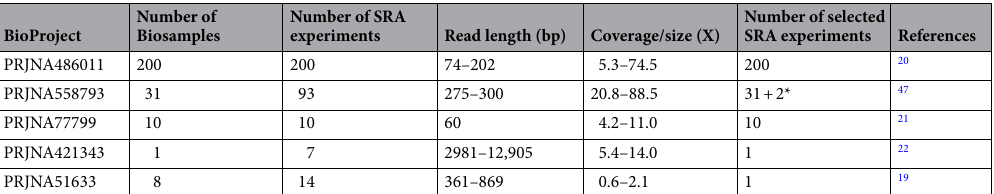
Table 3. Whole Genome Sequence (WGS) datasets used in the study. *Dataset directly downloaded from the NSF (project submitter) website (https:// plant scien ce. psu. edu/ resea rch/ labs/ guilt inan/ nsf- plant- genome- resea rch- progr